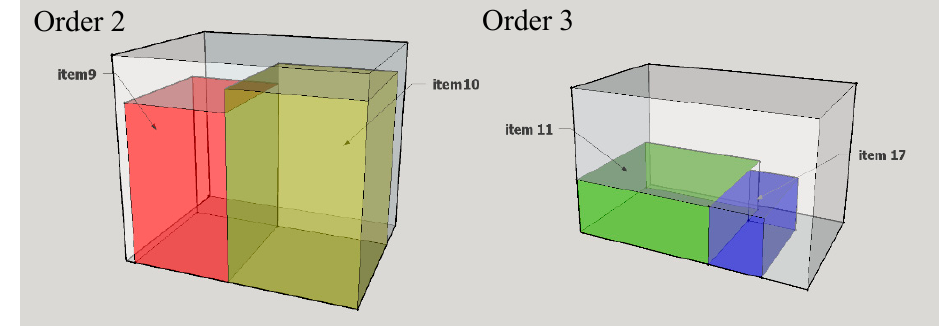
Figure 8. The load configuration of order 2 and order 3.